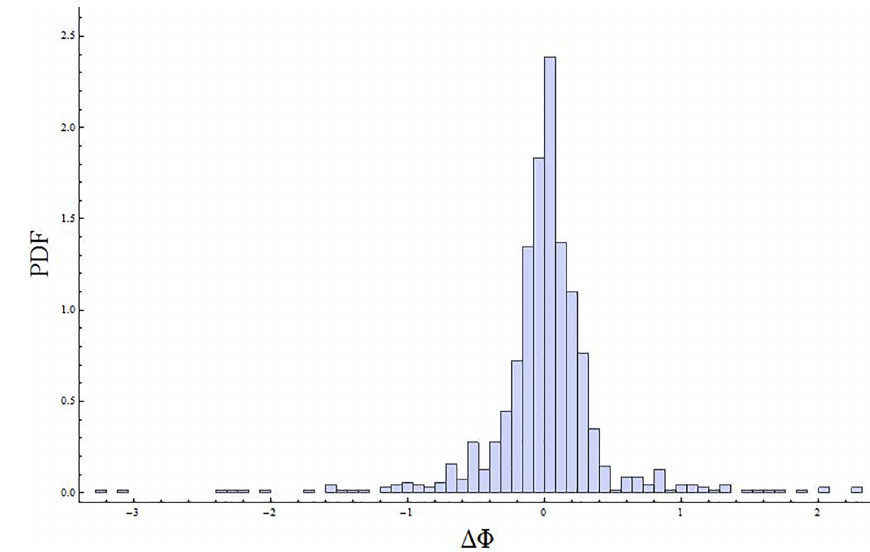
Figure 8. Histogram with bin width of 5 (cid:48) for Riccioli’s set of